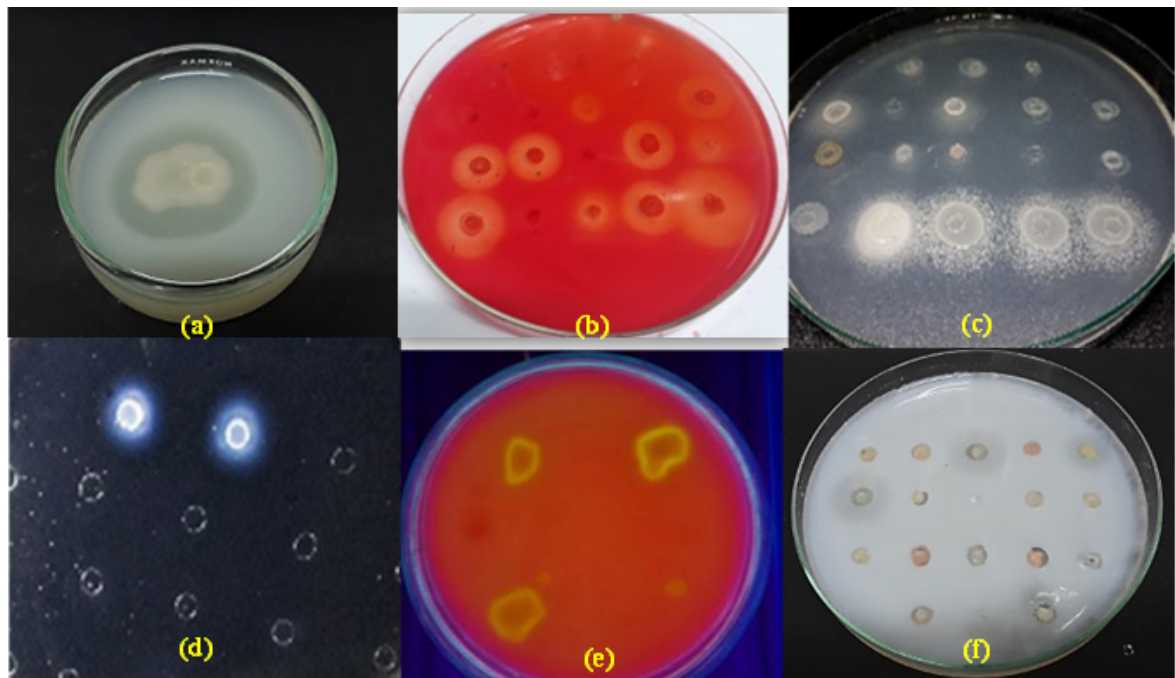
Figure 3. Positive production of extracellular enzymes by Antarctic yeasts isolated from different species of lichen: (a) protease, (b) cellulase, (c) esterase, (d) amylase, (e) lipase, (f) pectinase. The isolates were incubated at 15.0 ° C for 7